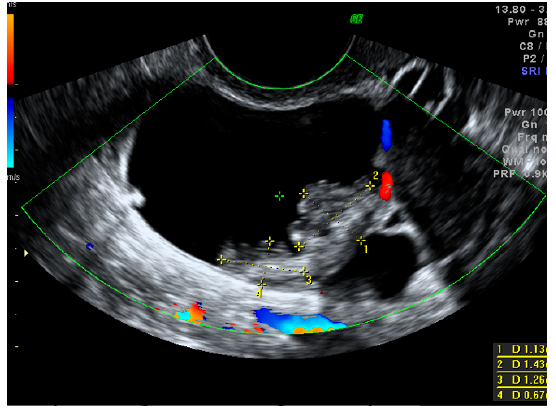
Figure 2. Largest papillary projection measurements in a small borderline ovarian cystic–solid mass. Tumor vascularity was assessed with a color score proposed by the IOTA group. A color score of 1 denotes that no color or power Doppler signal was found in the tumor, a score of 2 means that a minimal amount of color Doppler signals were detected, a color score of 3 means a moderate amount found and a score of 4 translates into abundant color Doppler signals being detected [28]. Figure 3 shows an example of IOTA color score 3 indicating a moderate vascularity in a solid adnexal mass.